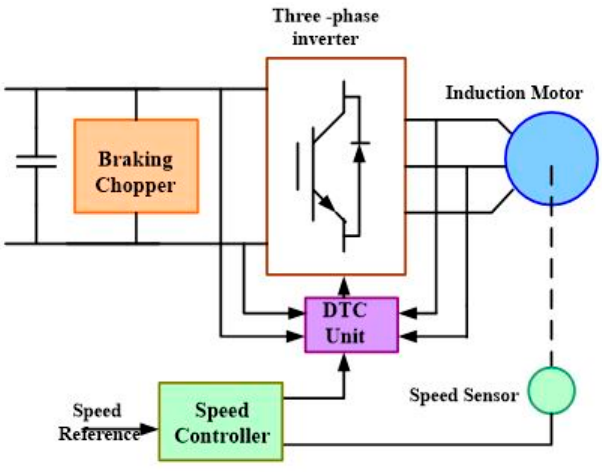
Figure 5. Electric drive schematic.